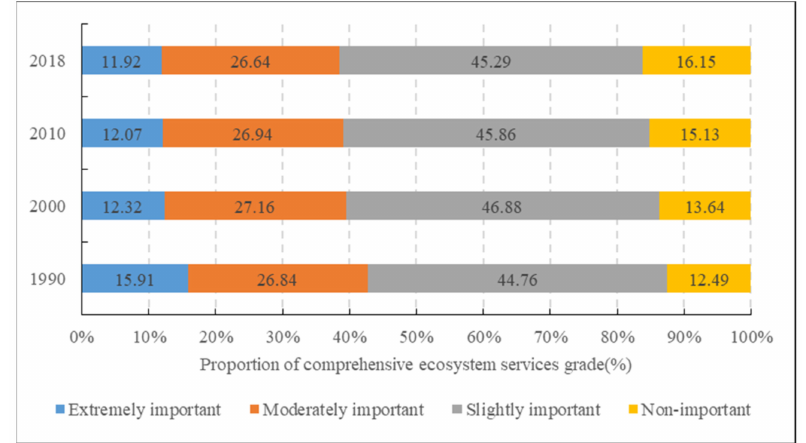
Figure 6. Area ratio of each integrated ecosystem service grade from 1990 to